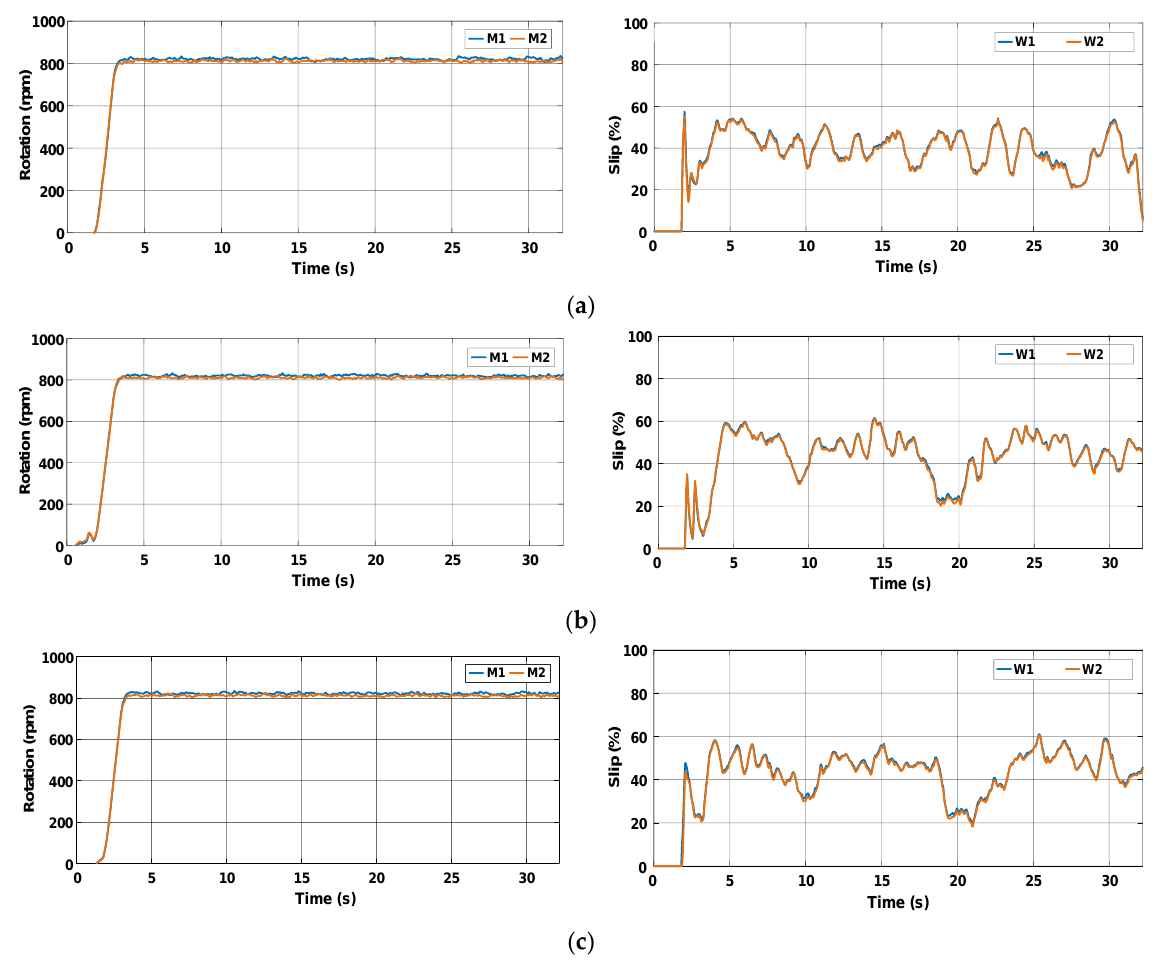
Figure 15. Rotation speed of electric motors and wheel slip during the trial sessions carried out on firm soil and without slip control. ( a ) T#1.1; ( b ) T#1.2; ( c )